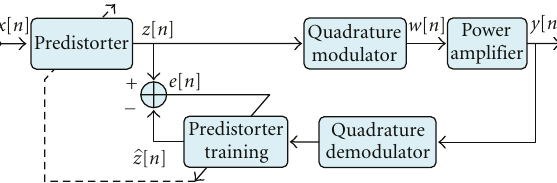
Figure 1: Block diagram of a direct-conversion transmitter with a predistortion linearization system.